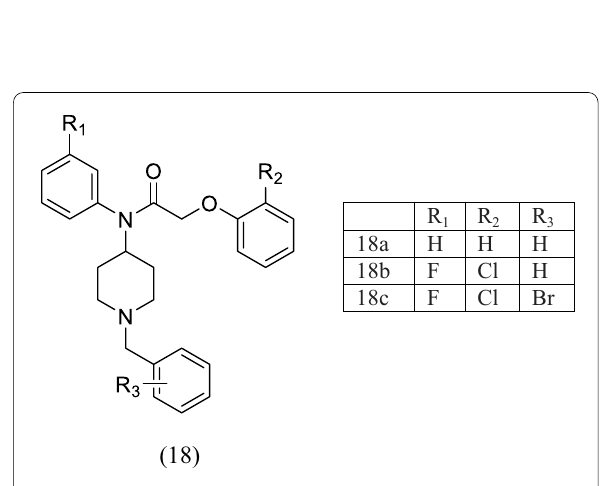
Fig. 23 Structure of phenylpiperidine‑4‑one oxime derivatives